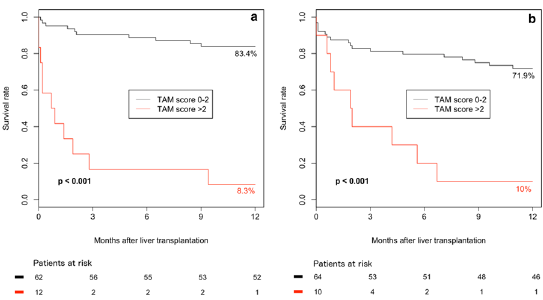
Fig. 1 Survival rate after liver transplantation in the training cohort (A, n 74) and in the validation cohort (B, n = low risk (black line) patients CO‑53 Does Echocardiography Improve Clinical Outcomes in